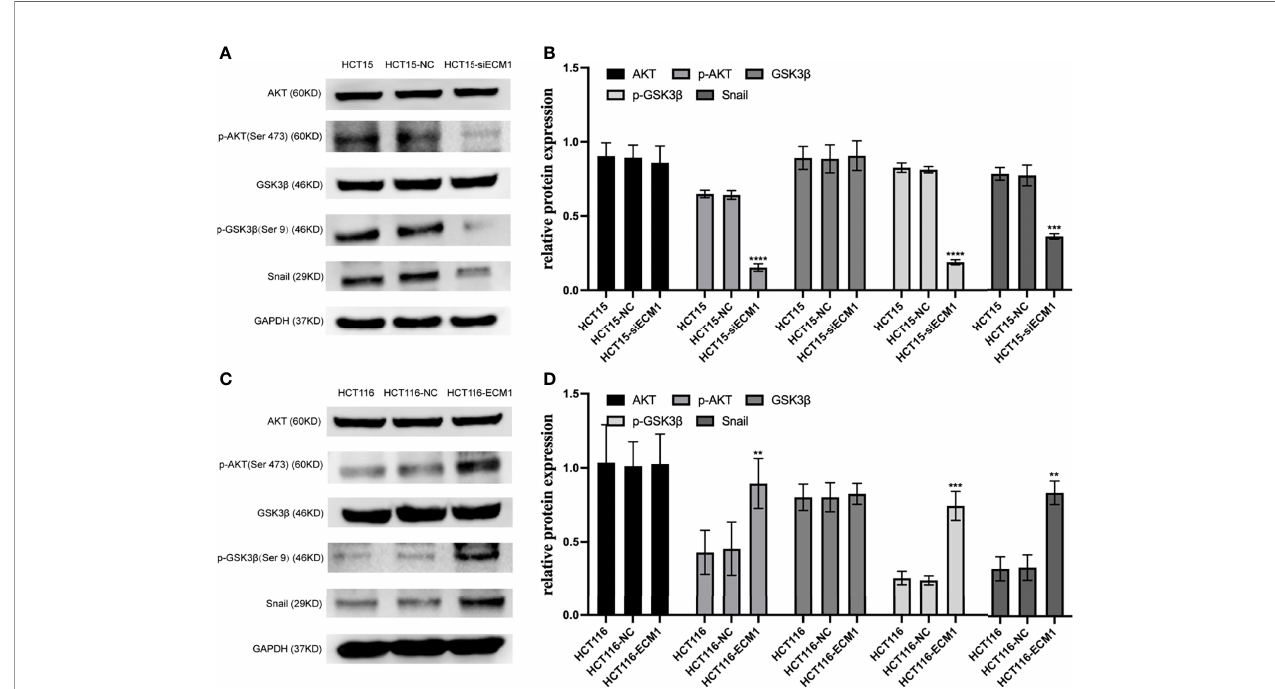
FIGURE 6 | ECM1 regulates signaling via the PI3K/AKT/GSK3 b /Snail axis within CRC cells. Western blotting was used to assess AKT, p-AKT, GSK, pGSK3 b , and Snail levels in CRC cells following (A, B) ECM1 knockdown or (C, D) ECM1 overexpression. Data are means ± SD (**P < 0.01, ***P< 0.001, ****P < 0.0001).